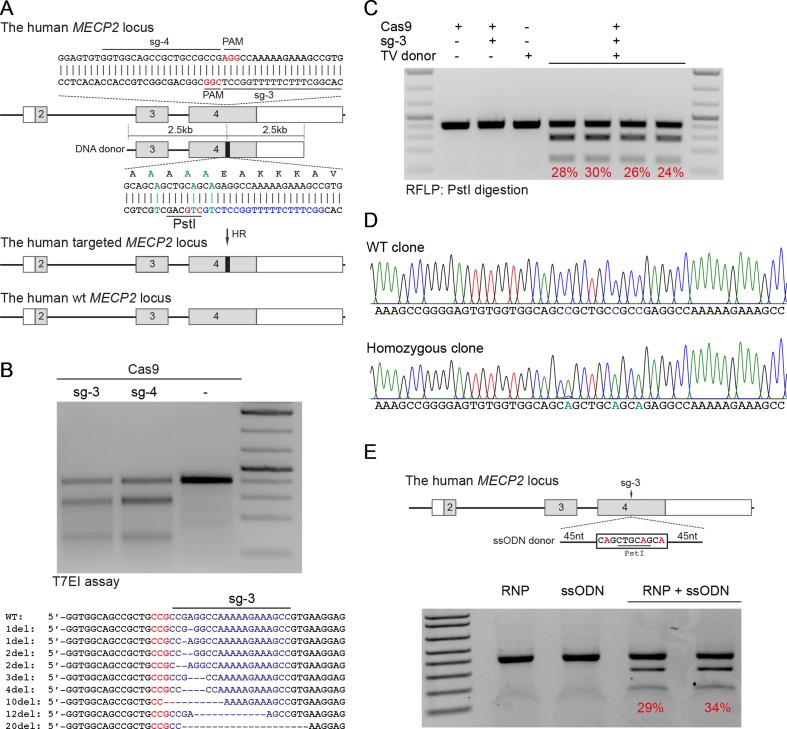
CRISPR/Cas9-mediated efficient precise modification in the MECP2 locus. (A) A strategy to knock-in silent mutations in the MECP2 exon 4. (B) T7EI assay showed the cutting efficiencies of two sgRNAs (above) and sequencing data (sg3) showed the INDELs of the targeted MECP2 sequence. (C) PstI-mediated restriction fragment length polymorphism (RFLP) assay showed the HR efficiency in HEK cells after 30 days of transfection, numbers indicate HR efficiency. (D) Sanger sequencing data of single-cell clone: wild-type (WT) and homozygous targeted clone (below). (E) A strategy to knock-in silent mutations in K562 cells using CRISPR/Cas9 RNP and ssODN as a repair template (above) and the RFLP assay to access the knock-in efficiency. Numbers in red represent for the band quantification-based knock-in efficiency. The data represent at least two independent experiments.